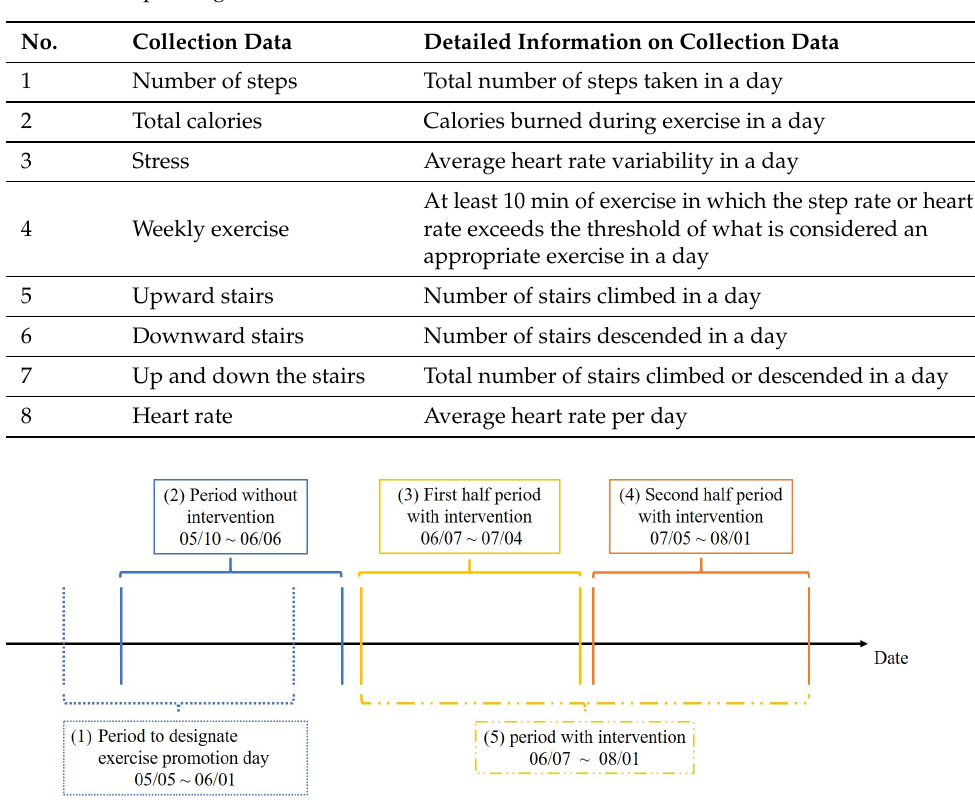
Table 1. The specific gait information.